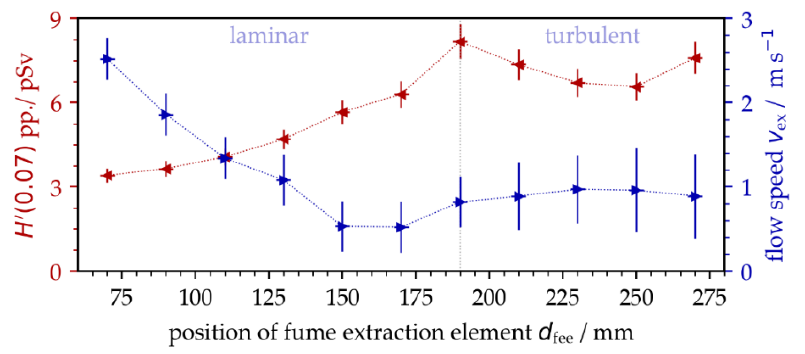
Figure 4. X-ray emission dose per pulse as a function of suction flow speed that was varied by increasing the distance of the fume extraction element from the laser processing area.